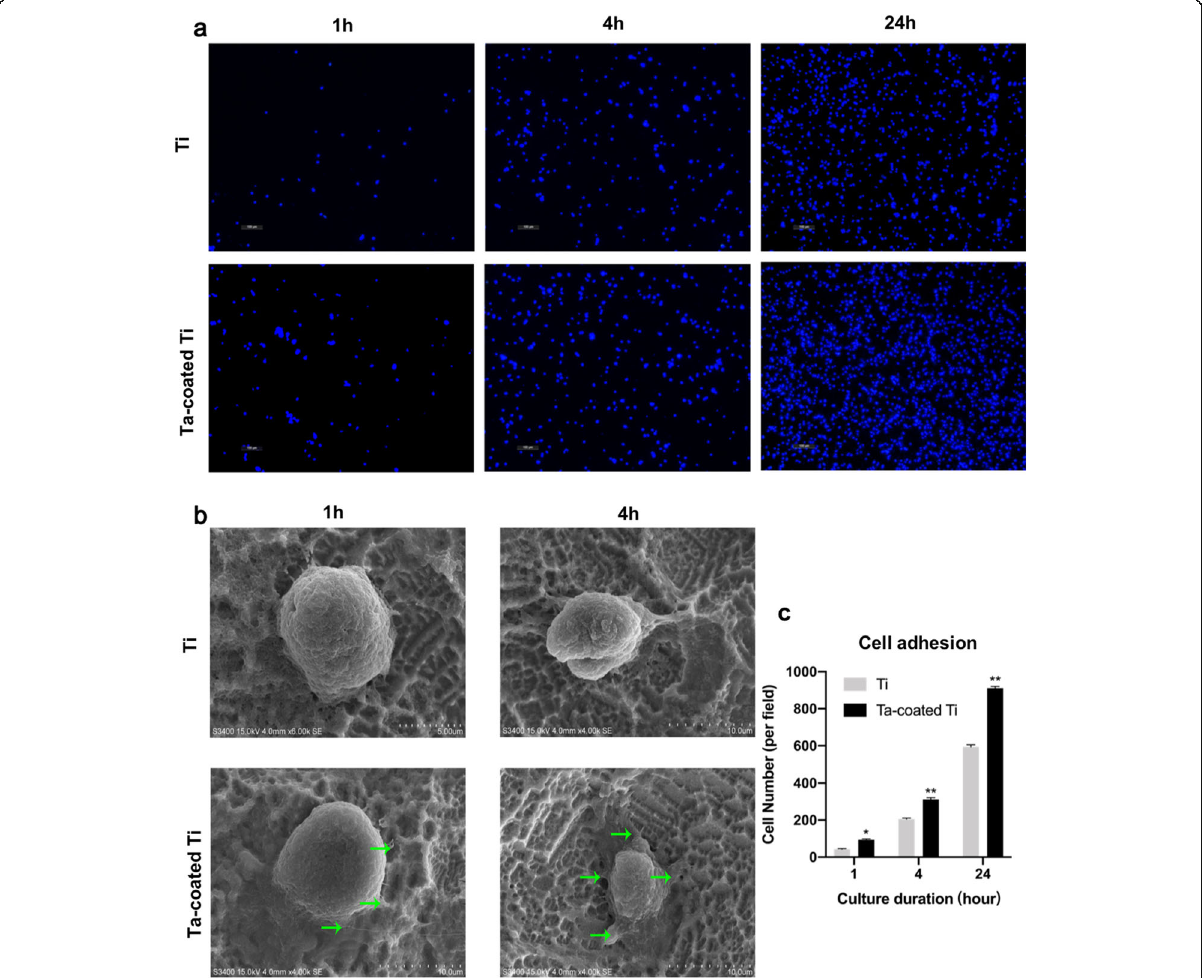
Fig. 3 a Cell adhesion assy. Cell nuclei stained with DAPI on both samples were imaged by confocal laser scanning microscopy at 1, 4, and 24 h after seeding (× 100). b SEM morphology of HGFs adhered on tantalum-coated titanium and titanium plates at 1 h and 4 h, noting that cells on Ta-coated Ti plates at 4 h with more extensively spread cytoplasm than those on Ti plates, the green arrow represented the filopodium-like projections of spreading gingival fibroblast cells. c Statistical results of adhesive cell numbers. * p < 0.001, ** p < 0.0001 when compared